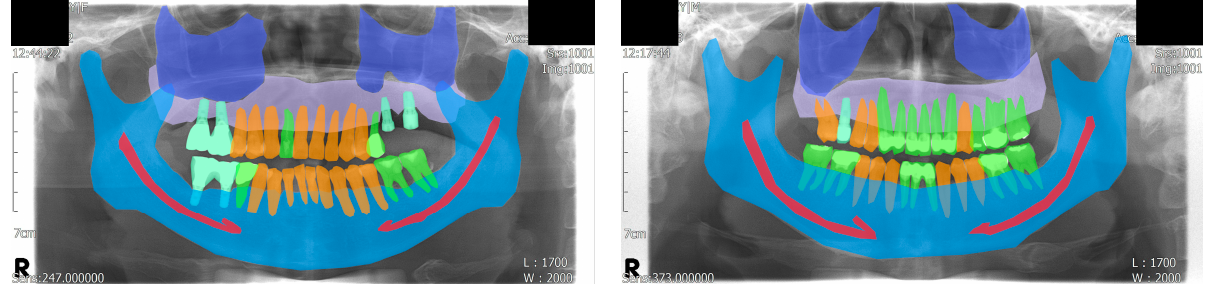
Figure 1. Visualized examples of the annotation results. A total of eight classes were used, including the background class. Four classes were assigned to semantic segmentation: maxillary sinus, maxilla, mandibular canal, and mandible. Three classes were assigned to instance segmentation: normal tooth, treated tooth, and dental implant.